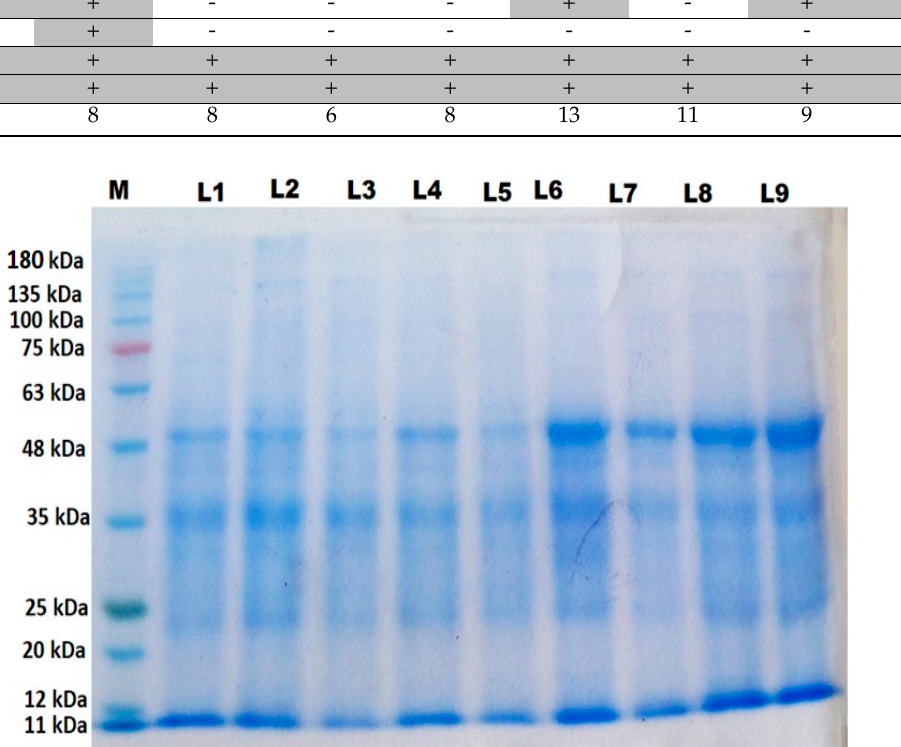
Figure 5. Changes in protein profile in leaves of wheat plants originated from irradiated grains and treated with stigmasterol. L1: Control, L2: 25 Gy, L3: 50 Gy, L4: 100 ppm stigmasterol, L5: 25 Gy + 100 ppm, L6: 25 Gy + 200 ppm, L7: 200 ppm stigmasterol, L8: 50 Gy + 100 ppm, L9: 50 Gy + 200